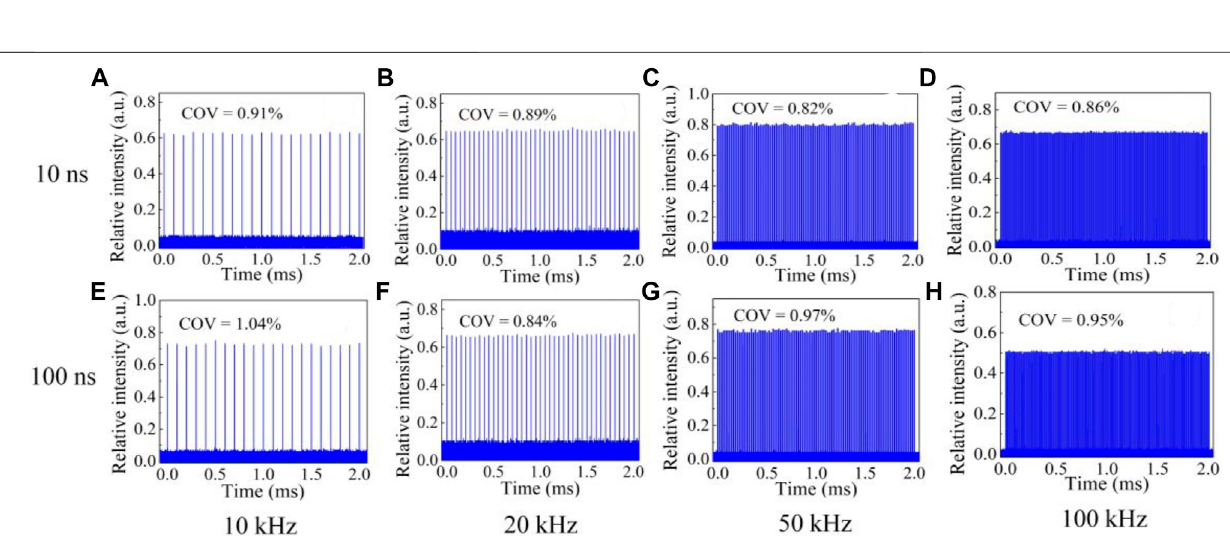
FIGURE 4 | Recorded output pulse-burst pro fi le at different repetition rates in terms of electric signal input with duration of 10 and 100 ns, respectively. (A) At 10 kHz repletion rate for 10 ns electric signal input. (B) At 20 kHz repletion rate for 10 ns electric signal input. (C) At 50 kHz repletion rate for 10 ns electric signal input. (D) At 100 kHz repletion rate for 10 ns electric signal input. (E) At 10 kHz repletion rate for 100 ns electric signal input. (F) At 20 kHz repletion rate for 100 ns electric signal input. (G) At 50 kHz repletion rate for 100 ns electric signal input. (H) At 100 kHz repletion rate for 100 ns electric signal